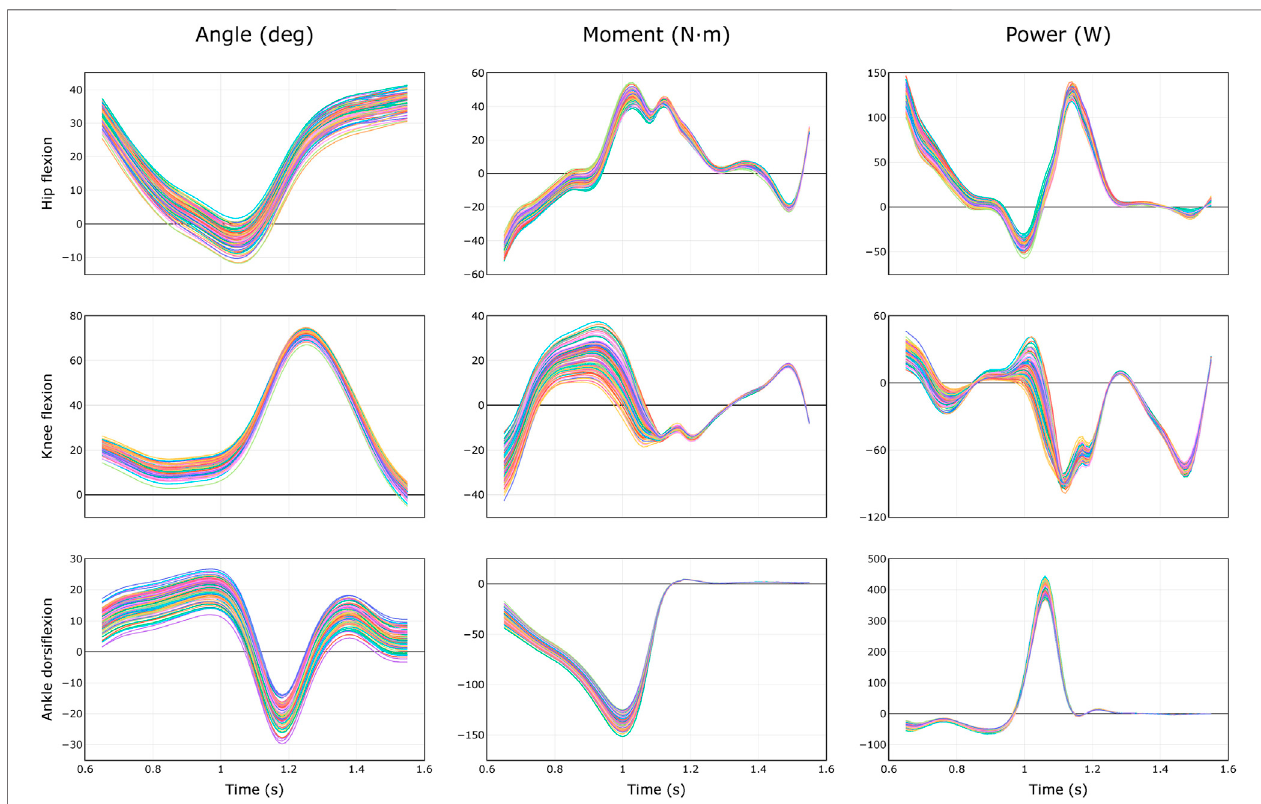
FIGURE 3 | Equally probable trajectories of joint angles, moments, and powers during healthy walking (Dembia et al., 2017) due to uncertainty of 2 cm in marker registration. Results from N = 100 models are shown.